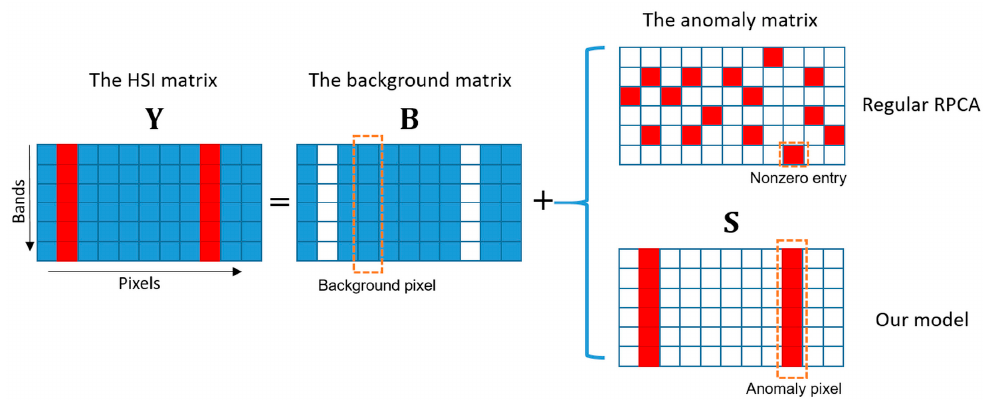
Figure 1. The modeling of background and anomalies. The red columns are spectral vectors of anomalies, where each red square denotes the spectral reflectance or digital number of an anomalous pixel in a band; the blues are spectral vectors of background pixels; and the whites denote zero columns in the matrix.